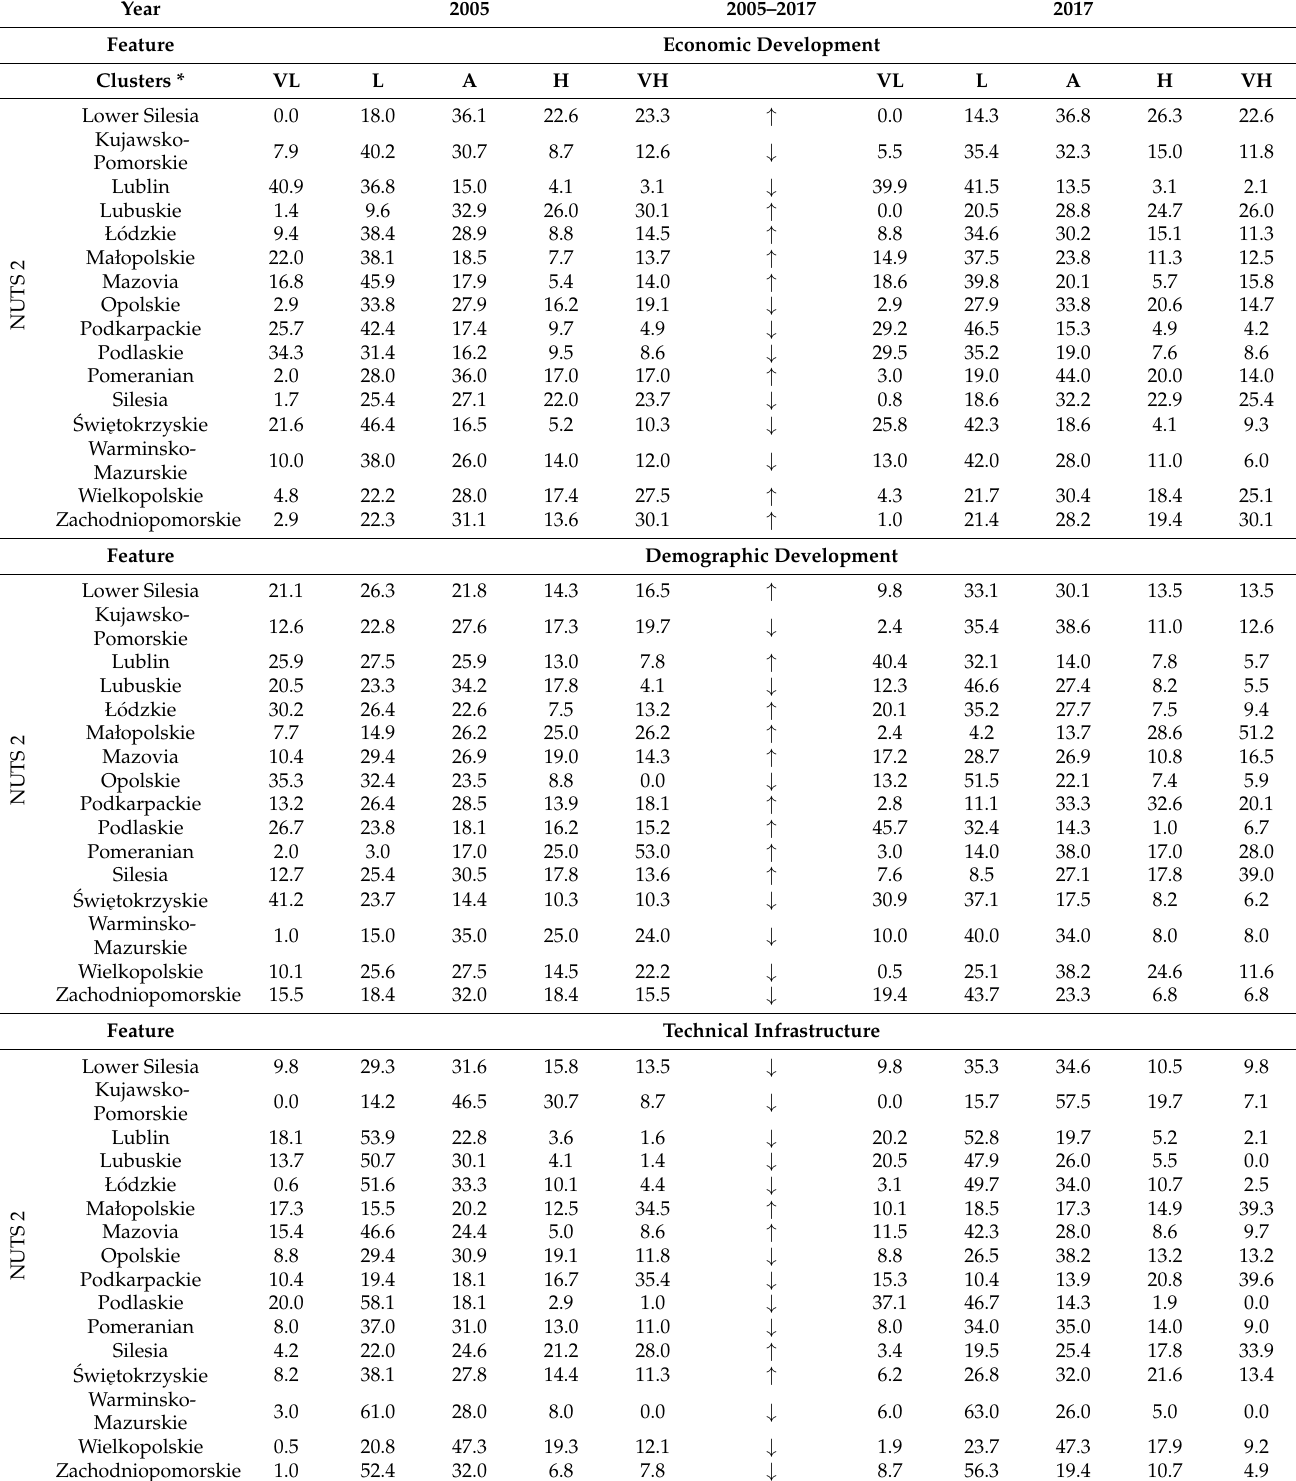
Table 3. Level of estimated development measures (Hellwig’s) by region (NUTS 2) in 2005 and